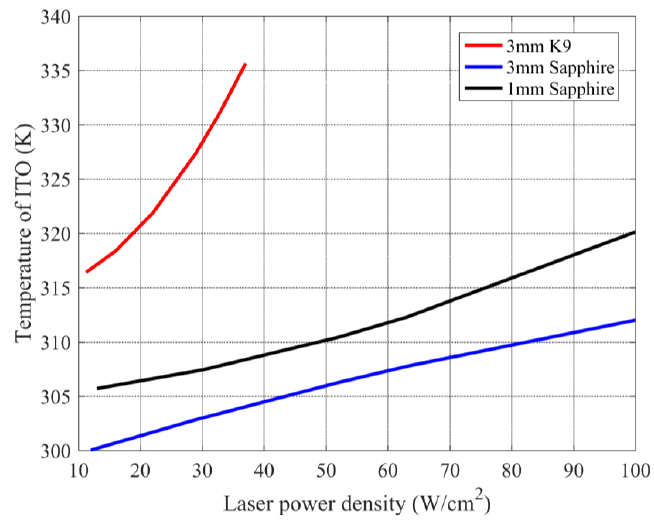
Figure 6. The temperature of ITO tested on different substrates varies with laser power density.